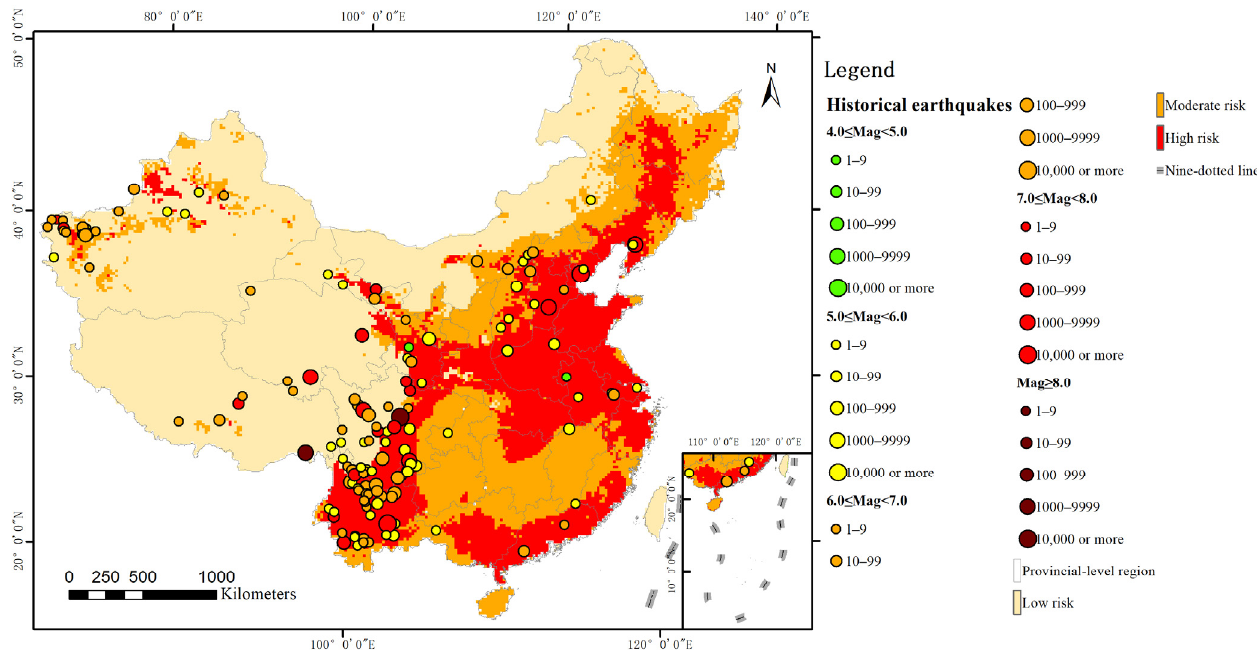
Figure 12. Distribution of risk zones and historical earthquake in China’s mainland.